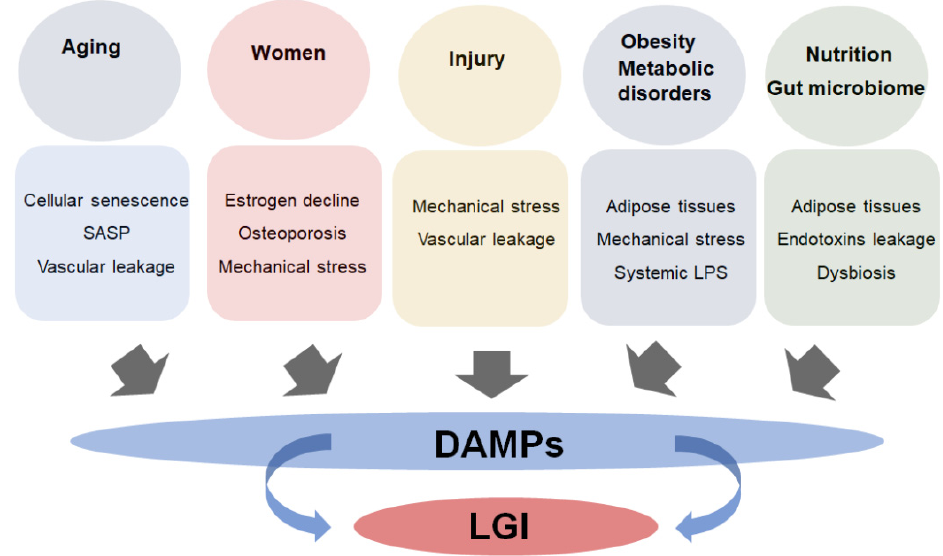
Figure 3. Association between LGI state and the risk factors of OA. Factors including aging, sex (women), injury, obesity and metabolic syndromes, nutrition, and gut microbiome are associated with increased production of DAMPs in the tissues, which facilitate the development of LGI.